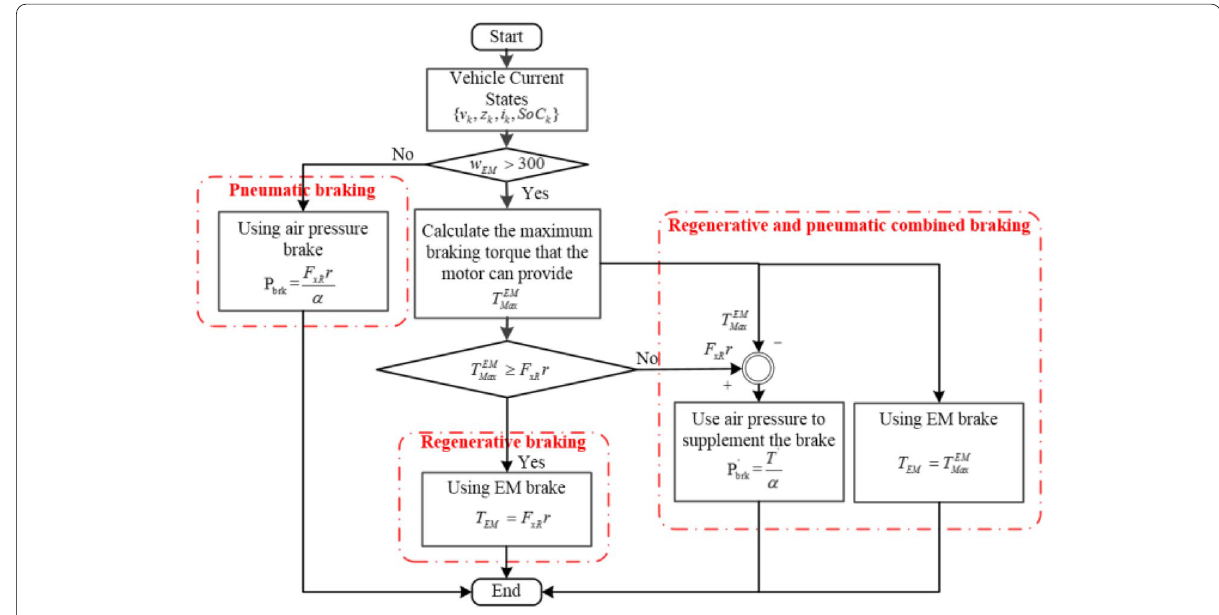
Figure 7 Distribution of regenerative braking and friction